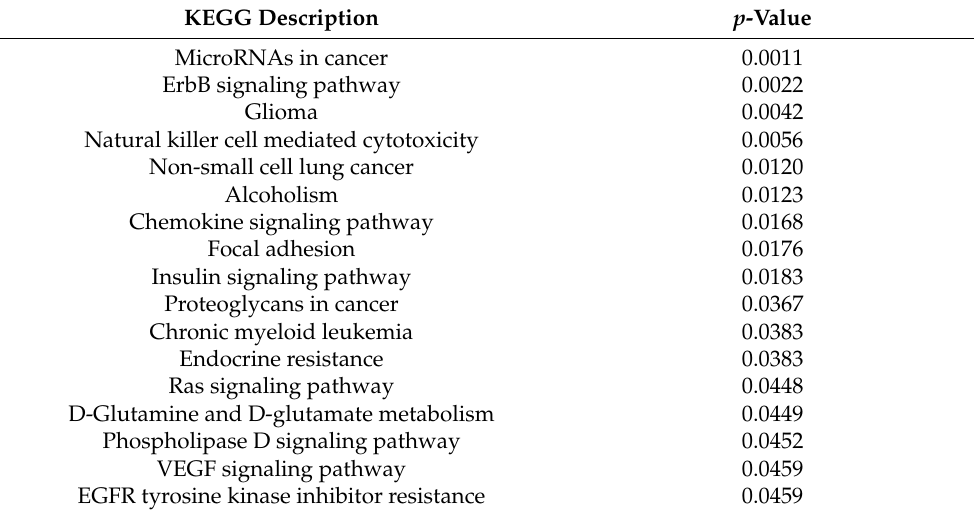
Table 1. KEGG enriched pathways associated with the pathogenicity of SHVV. KEGG Description p -Value MicroRNAs in